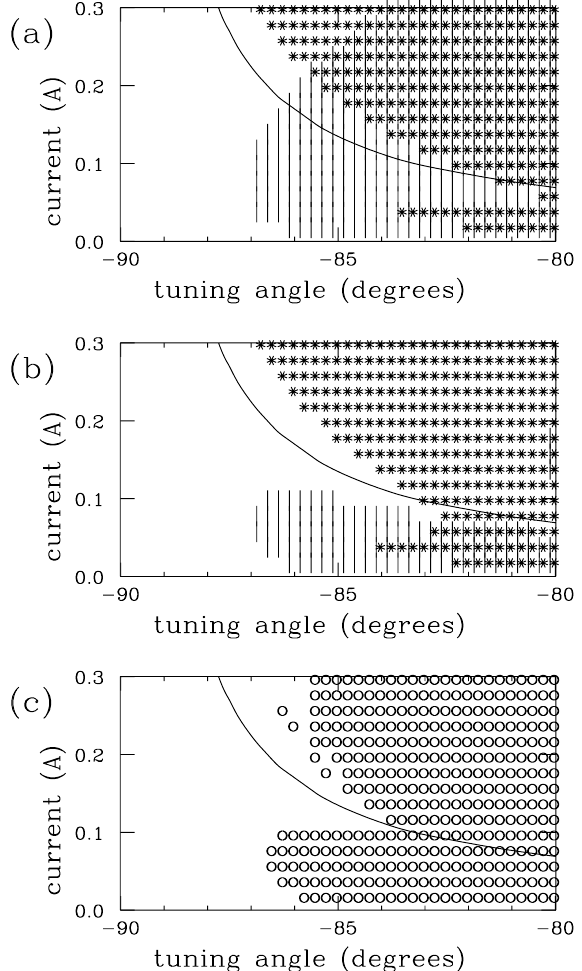
FIG. 1. (a) Robinson instabilities are predicted without consid- eration of mode coupling, for passive Landau-cavity operation with the Aladdin lattice and a fundamental rf voltage of 90 kV. A solid curve shows the parameters for optimal bunch lengthening, in which case the linear synchrotron frequency is zero. A symbol is plotted when Robinson instability is predicted for a given ring current and Landau-cavity tuning angle. Vertical line: dipole instability; *: quadrupole instability. (b) Dipole-quadrupole mode coupling is included in Robinson instability predictions. In this case, the dipole and quadrupole modes are perturbed by the coupling, but a fast mode-coupling instability is not predicted. Vertical line: coupled-dipole instability; *: coupled-quadrupole instability. (c) Instabilities observed in 500 000 turn simulations. When the relative energy spread at the end of a simulation ex- ceeds the natural value (cid:3) 4.8 3 10 2 4 (cid:4) by $ 10% , a circle is plot- ted to signify